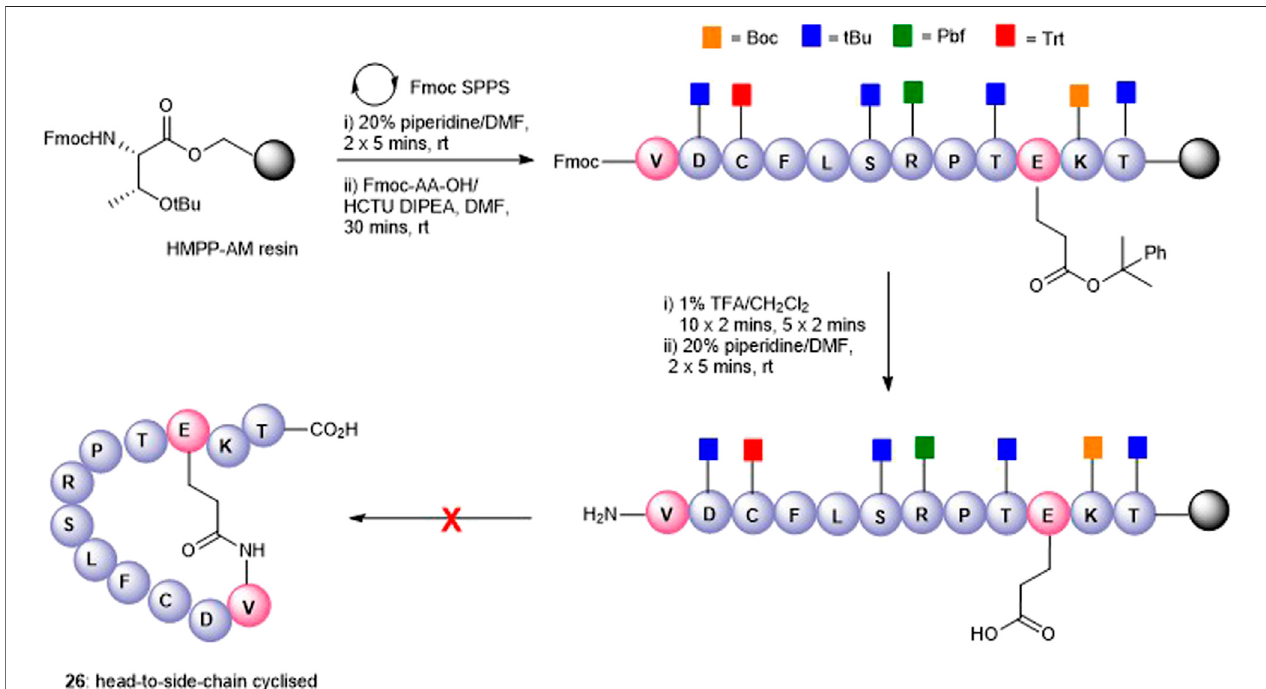
FIGURE 5 | Unsuccessful synthesis of Glu10-Val1 side-chain-to-head cyclized peptide5 26 .